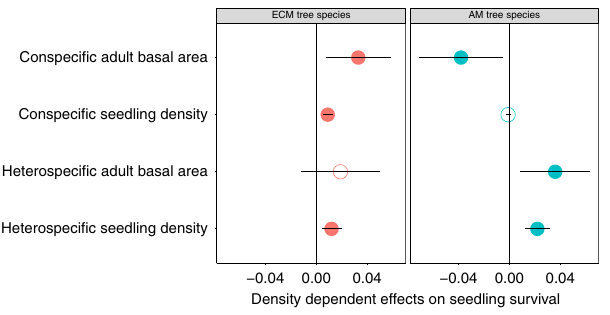
Fig. 1 Density-dependent effects on fi rst-year survival for ectomycorrhizal (ECM) and arbuscular mycorrhizal (AM) tree seedlings. Left panel: ECM tree species. Right panel: AM tree species. For all of the 17,824 seedlings that were newly germinated during 2009 – 2016, we analysed their survival over the fi rst year using a generalized linear mixed- effects model, in which we entered conspeci fi c seedling density, heterospeci fi c seedling density, conspeci fi c adult density and heterospeci fi c adult density as fi xed factors, and species, recruitment year and location of each seedling as random factors, assuming a logit-link function and binomial error. Values represent regression coef fi cients and associated 95% con fi dence intervals. Bold solid circles indicate signi fi cant at P < 0.05, and hollow circles indicate non-signi fi cant differences with